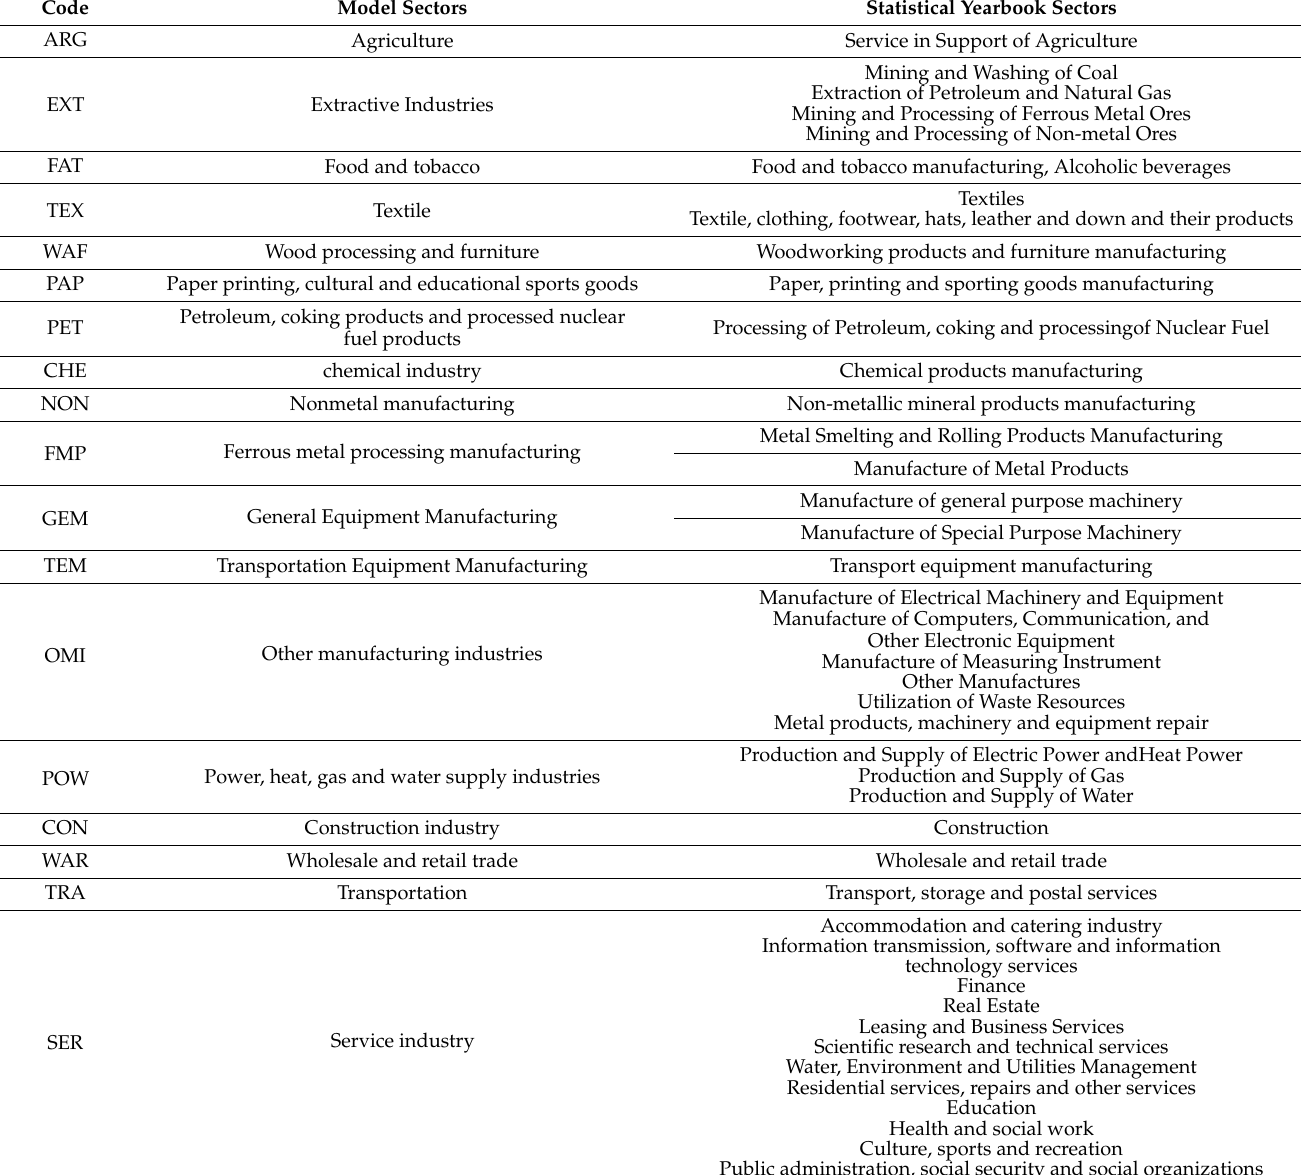
Table A1. Correspondence between model sectors and statistical yearbook sectors.